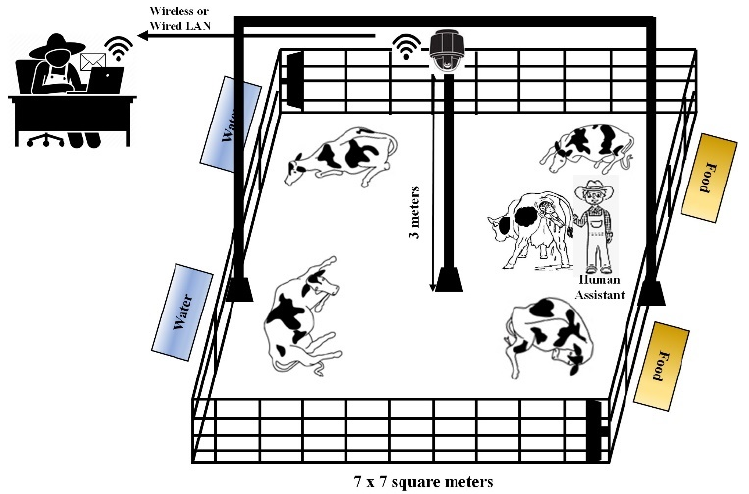
Figure 1. Demonstration of our research work.